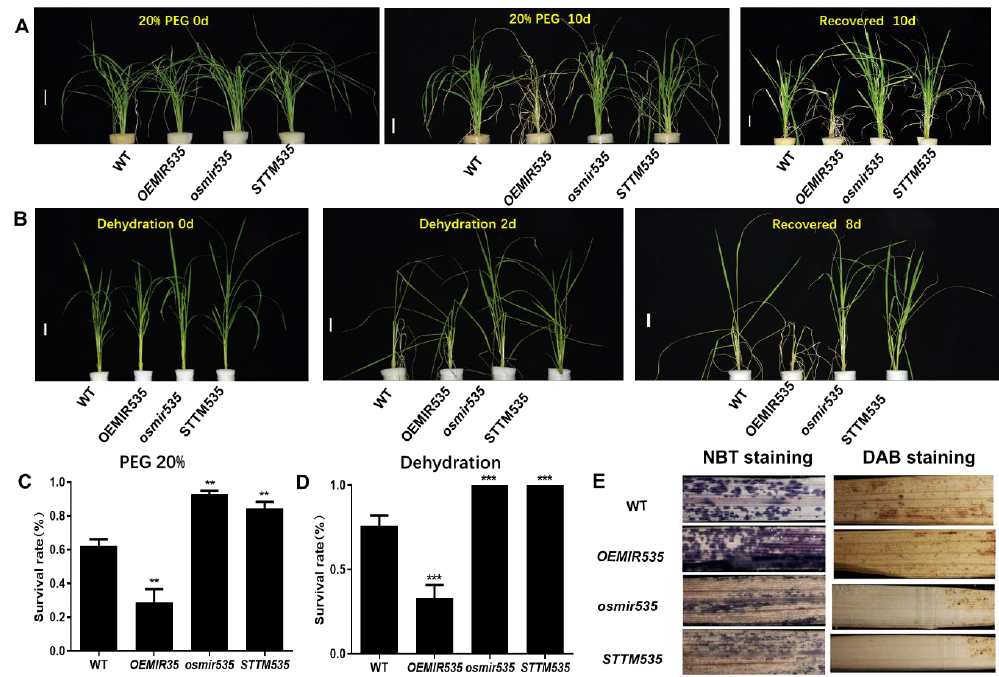
Figure 4. Identification and drought-tolerance tests of OsmiR535 overexpression, STTM inhibition, and CRISPR/Cas9 knockout plants. ( A ) The phenotype of rice seedlings grown in hydroponic solutions containing 20% PEG for 10 days and recovery for 10 days. ( B ) The phenotype of rice seedlings grown after 2 days of dehydration and recovery for 8 days. ( C ) The survival rate (%) of WT and transgenic lines after 10 days of PEG-induced stress recovery. ( D ) The survival rate (%) of WT and transgenic lines after 2 days of dehydration stress recovery. ( E ) NBT (Nitroblue tetrazolium) and DAB (3,3-diamino benzidine) staining of dehydration-stressed plant leaves. One asterisk( *), double asterisk( **), triple asterisk (***) or quadruple asterisk (****) represents p < 0.05, p < 0.01, p < 0.001 or p < 0.0001 or statistical difference from the controls, respectively.